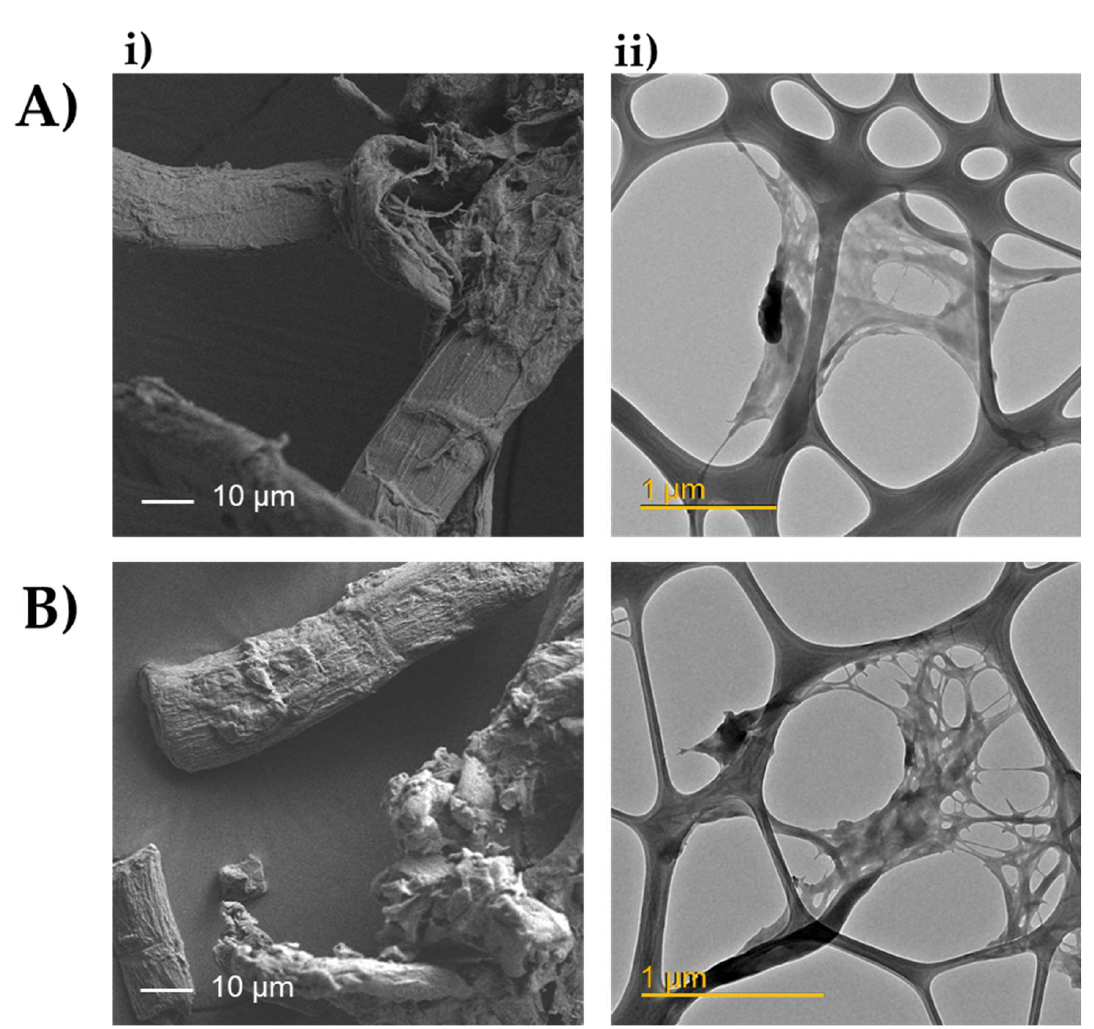
Figure 5. Representative FE-SEM (500× magnification) (i) and TEM (ii) images of ( A ) HC and ( B ) CM reference material.